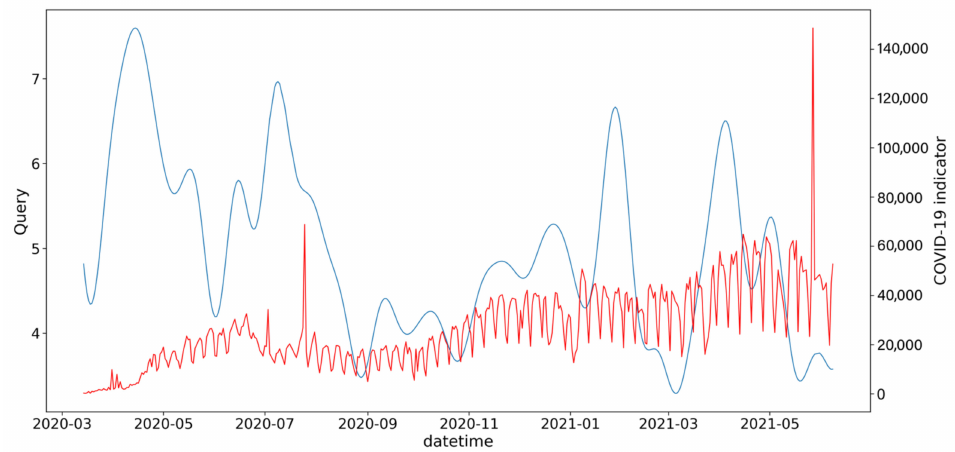
Figure A11. COVID-19 indicator—New tests. Query—vaccination COVID-19 vaccine.